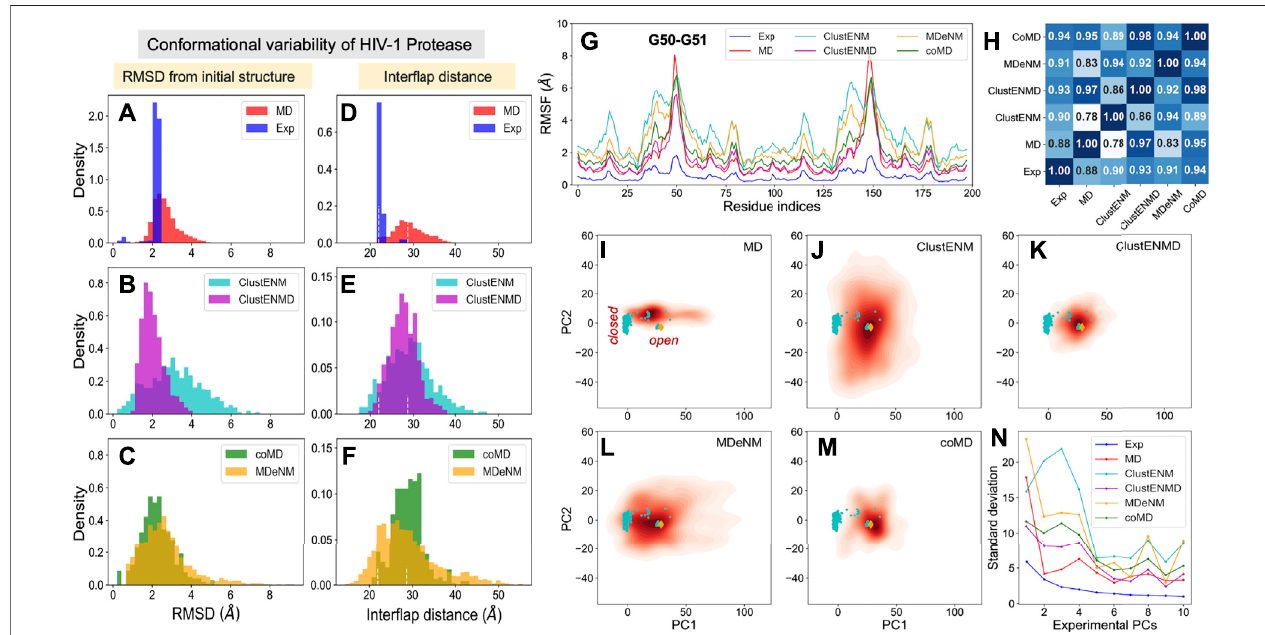
FIGURE 2 | Comparison of computational and experimental ensembles of HIV-1 PR. Histograms: (A – C) RMSDs with respect to the starting open structure (PDB id: 1tw7). (D – F) Distances between α − carbons of K55 on different subunits that monitors the opening/closure of fl aps. Dashed lines indicate the distances of the initial open structure and a closed crystal structure (PDB id: 1bve). The distribution for each ensemble, namely experimental ( blue ), MD ( red ), ClustENM ( cyan ), ClustENMD ( magenta ), coMD ( green ), and MDeNM ( orange ), is shown on the shared x-axis. (G) RMSFs as a function of residue index for each ensemble, (H) Pearson correlation coef fi cients between all pairs of RMSF pro fi les. (I – M ) Population distributions of ensembles of conformers generated by simulations, projected onto the subspace spanned by experimental e PC1 and e PC2, shown for (I) MD simulations, (J) ClustENM, (K) ClustENMD, (L) MDeNM, and (M) coMD. Cyan circles represent the experimental structures, and the orange diamond is the initial structure (PDB id: 1tw7). (N) Standard deviations of the conformers projected along the experimental